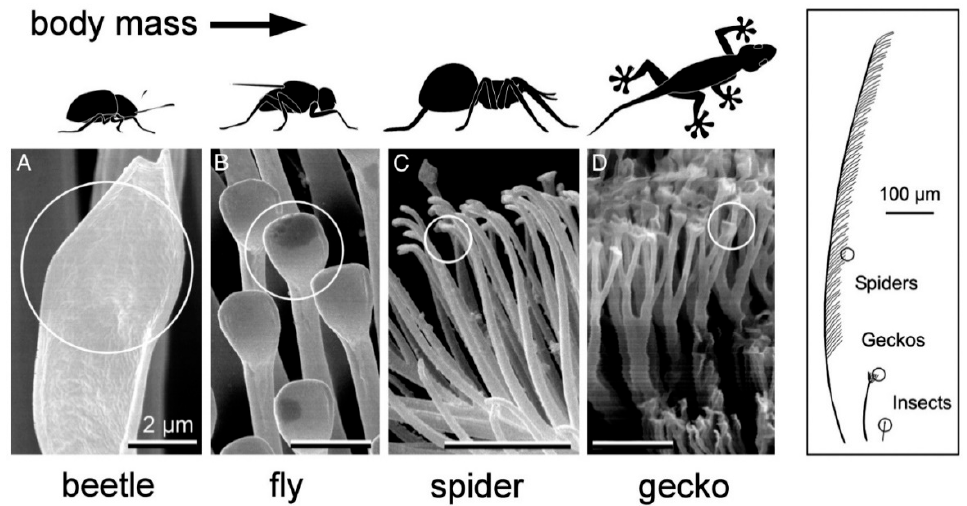
Figure 20. Animals and insects with widely varying body weight, such as flies, spiders, and geckos, can adhere to and move along vertical walls and even ceilings. Terminal elements (circles) in animals with hairy attachment pads. Note that adhesion structures are finer in animals with heavier body mass [268]. © PNAS, 2002.